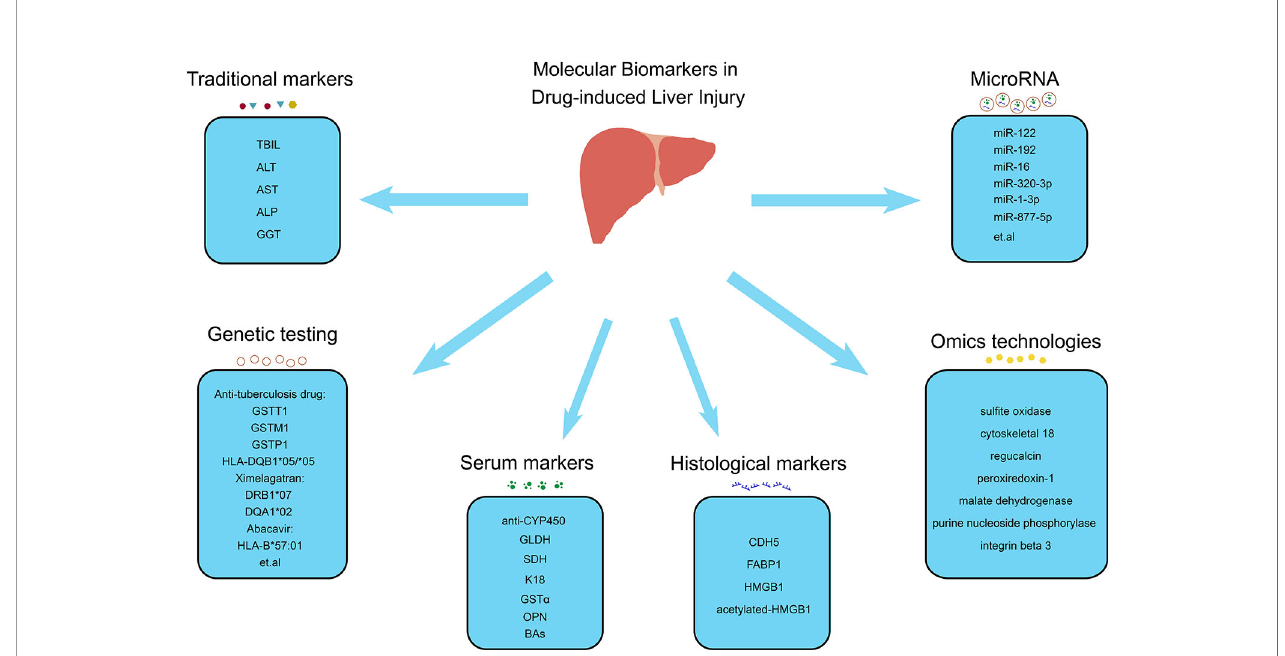
FIGURE 1 | Molecular biomarkers in drug-induced liver injury. Molecular biomarkers of DILI include traditional markers (TBIL, ALT, AST, ALP and GGT), serum markers (anti-CYP450, GLDH, SDH, K18, GST a , OPN and BAs), histological markers (CDH5, FABP1, HMGB1 and acetylated-HMGB1), microRNA (miR-122, miR- 192, miR-6, miR-320-3p, miR-1-3p, miR-877-5p, etc.), genetic testing (GSTT1, GSTM1, GSTP1 and HLA-DQB*05/*05 associated with antituberculosis drugs, DRB1*07 and DQA1*02 associated with ximelagatran and HLA-B*57:01 associated with abacavir, etc.), and omics technologies (sul fi te oxidase, cytoskeletal 18, regucalcin, peroxiredoxin-1, malate dehydrogenase, purine nucleoside phosphorylase, and integrin beta 3). TBIL, total bilirubin; ALT, alanine aminotransferase; AST aspartate aminotransferase; ALP, alkaline phosphatase; GGT, glutamyl transpeptidase; anti-CYP450, CYP450-antibodies; GLDH, glutamate dehydrogenase; SDH, sorbitol dehydrogenase; K18, keratin 18; GST a , glutathione-S-transferase alpha; OPN, osteopontin; BAs, bile acids; CDH5, cadherin 5; FABP1, fatty acid binding protein 1; HMGB1, high mobility group box-1